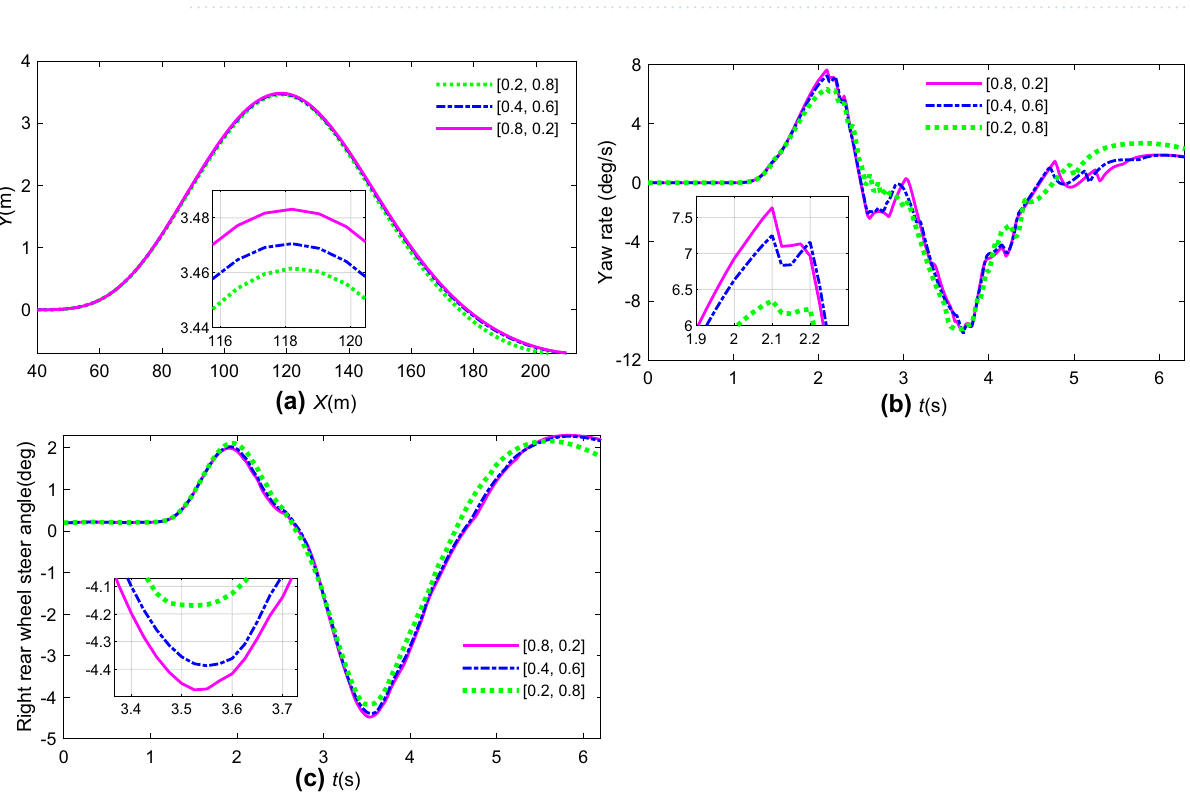
Figure 13. State response comparison at different weight matrices: ( a ) path tracking; ( b ) yaw rate; ( c ) rear steering